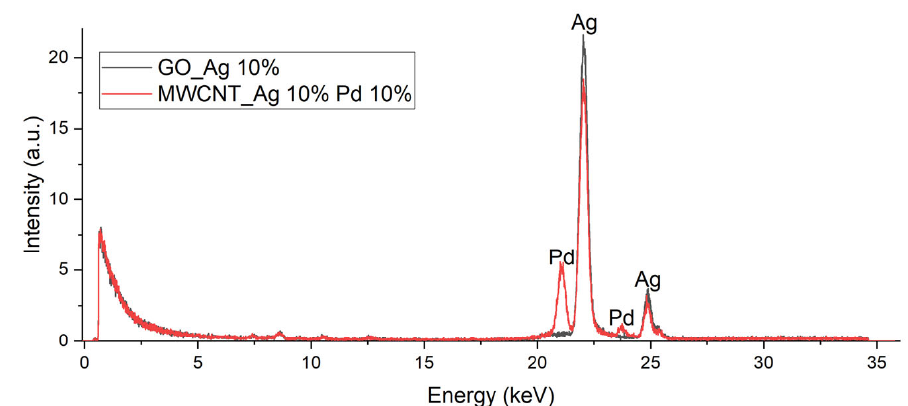
Figure 5. XRF spectrum of samples GO_Ag 10% and MWCNT_Ag 10% Pd 10%. To study the effectiveness of the synthesized catalysts based on carbon nanotubes (CNTs) and graphene oxide (GO) an electrochemical experiment in the modes of linear and cyclic voltammetry was conducted. Figure 6 shows the results of linear voltammetry of the studied catalysts.